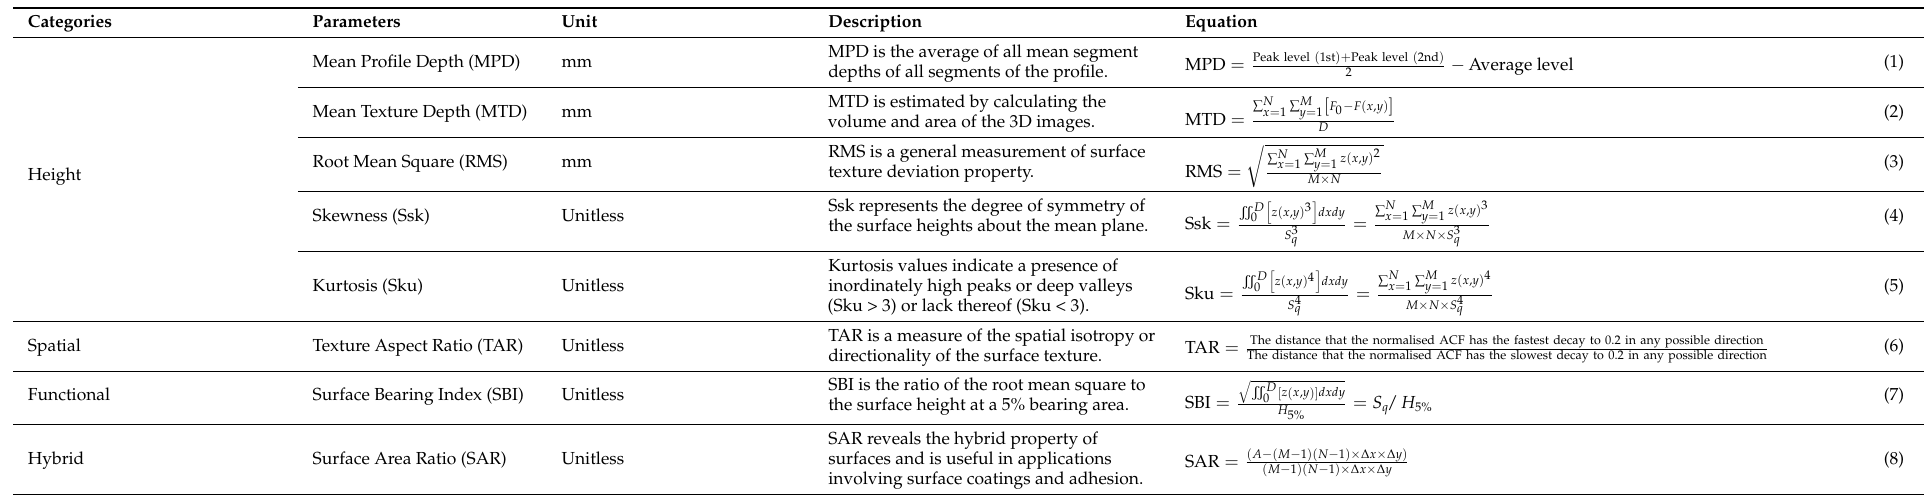
Table 3. Summary of 3D texture